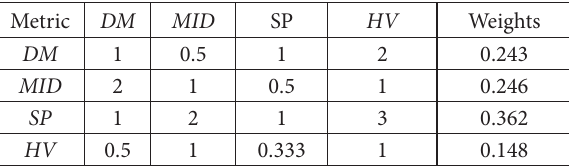
Table 6. The result of the TOPSIS method for case studies Normalize decision Weighted normalized Decision matrix matrix decision